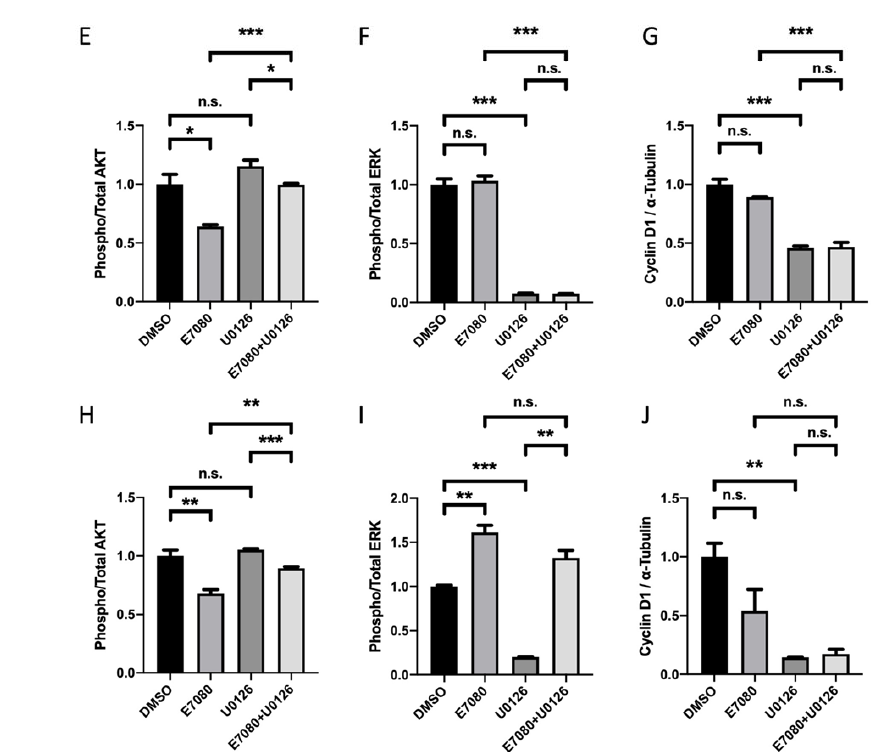
Figure 2. The synergistic effect of lenvatinib (E7080) plus MEK inhibitor in vitro. ( A – C ) Lenvatinib plus an MEK inhibitor, U0126, inhibited cell proliferation more potently than monotherapy with either lenvatinib or U0126 in 8505C and TCO1 cell lines (** p < 0.01, *** p < 0.001). ( D ) Western blot analysis shows that lenvatinib inhibited phosphorylation of AKT and U0126 inhibited phosphorylation of ERK and cyclin D1 in 8505C and TCO1 human ATC cells. Quantification of band density is shown for 8505C ( E – G ) and TCO1 cells ( H – J ). * p < 0.05, ** p < 0.01, *** p < 0.001, n.s.: not